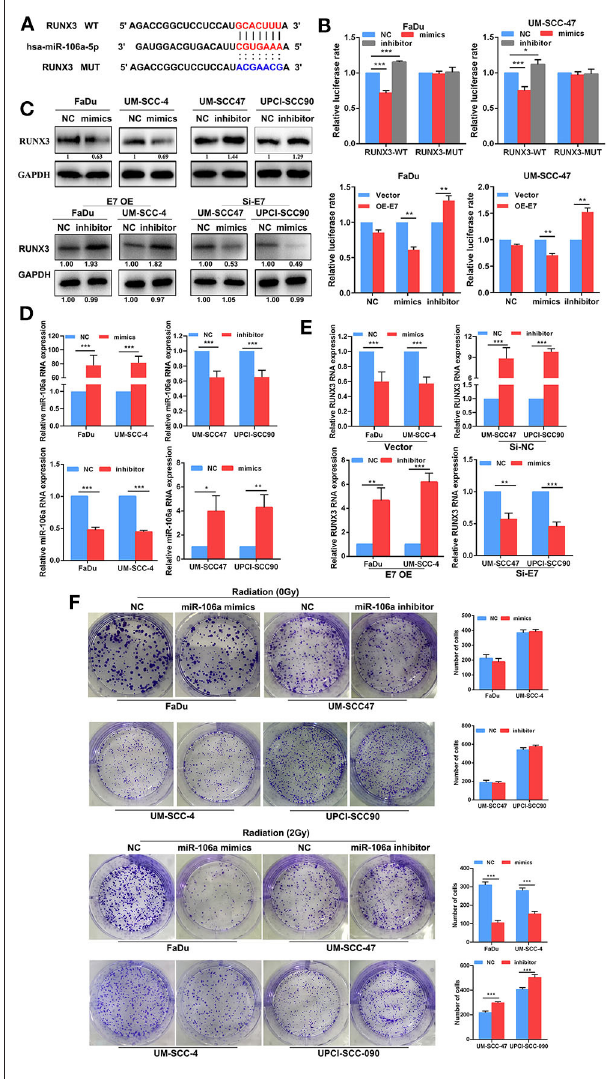
FIGURE 3 | Hsa-miR-106a inhibits the expression of RUNX3 and enhances radiation sensitivity. (A) Alignment of the predicted miRNA binding sites in the 3 ′ untranslated region (UTR) of the RUNX3 mRNA. (B) Luciferase reporter gene demonstrated that hsa-miR-106a directly targeted the 3 ′ UTR of RUNX3. (C) The protein expression of RUNX3 in FaDu, UM-SCCC-4, UM-SCC47, and UPCI-SCC90. (D) Hsa-miR-106a transfection efficiency was measured by RT-qPCR. (E) The mRNA expression of RUNX3 in human papillomavirus (HPV)-negative cells with hsa-miR-106a overexpression and HPV-positive cells with hsa-miR-106a silencing. (F) The sensitivity of the cells to radiation was detected by clonogenic survival with the condition of hsa-miR-106a overexpression in HPV-negative cells and hsa-miR-106a silencing in HPV-positive cells. * p < 0.05, ** p < 0.01, *** p < 0.001.